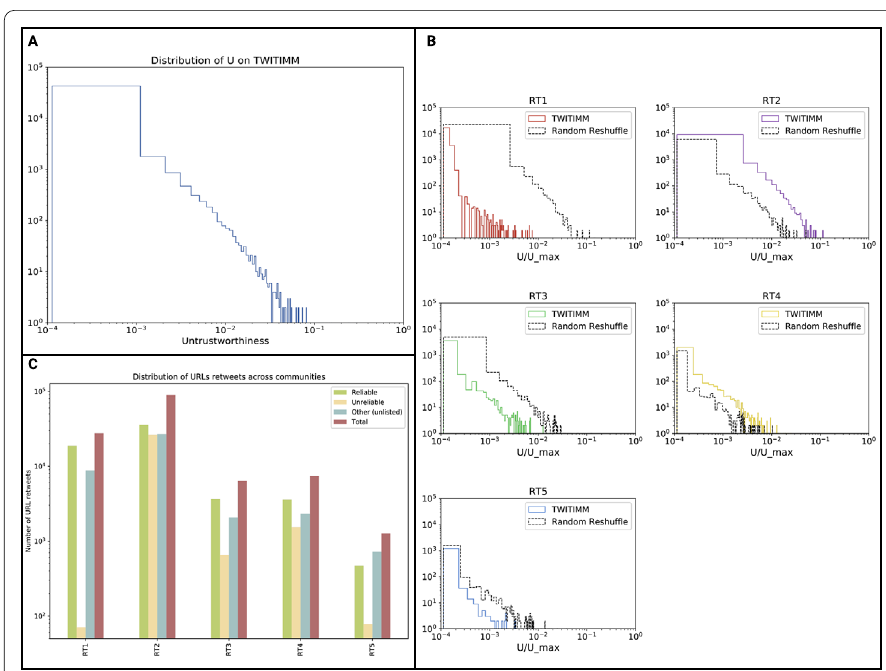
Figure 1 ( A ) Distribution of the Untrustworthiness index of Twitter accounts in TWITIMM, i.e., accounts involved in the immigration debate. The numbers, weighted by the activity of the users, tend to be very low; in logarithmic scale we can see that the vast majority of the users have low U, but the right tail of the distribution decreases slowly, highlighting a core of high- U users at the very end of the distribution; ( B ) Distribution of U disaggregated by clusters and tested against a randomly reshuffled community partitioning. All the distributions are statistically non-random according to the Mann-Whitney test ( p ≤ 10 –4 ). We see how RT2, identified as an anti-immigration cluster, clearly exceeds the average number of high- U users by far, showing a higher and longer right tail than the other communities, suggesting that the prevalence of low credibility media outlets in this cluster is much higher. ( C ) Shares of URLs disaggregated by community and by type of URL. Links to reliable and unreliable outlets are those that concur with the calculation of the Untrustworthiness score (i.e., users showing a striking preference for one type or the other can be classified, respectively, as trustworthy and untrustworthy), while the category other includes all URLs that do not belong to our lists, thus not contributing to the calculation of U. We observe very different sharing patterns between the communities, with users in some sharing a significantly higher number of reliable URLs, while others show smaller differences between reliable and unreliable media outlets. Differences have been statistically tested as shown in Tab.